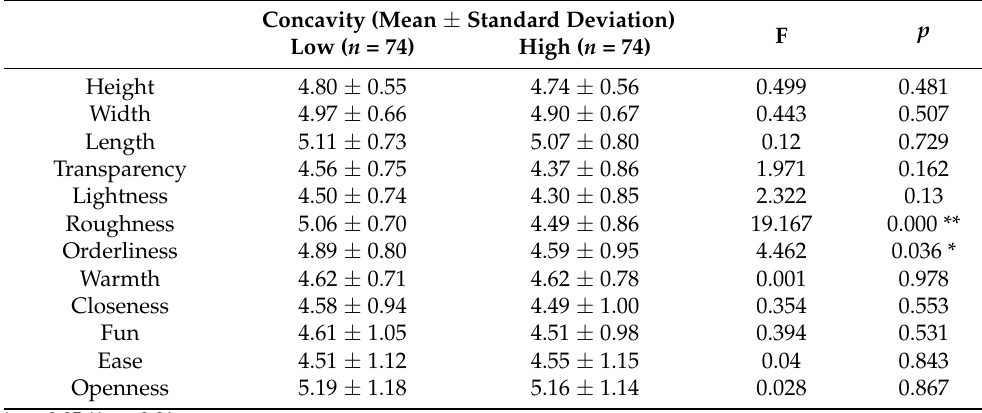
Table 13. Variance analysis of concave/convex degree classification.